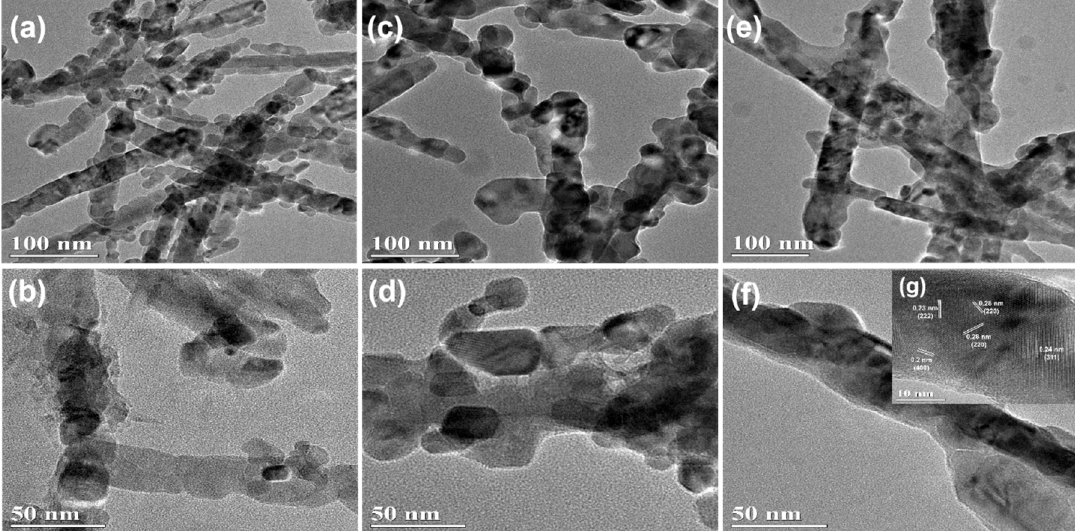
Figure 3. Transmission electron microscopy (TEM) image of ( a,b ) NiCo 2 O 4 , ( c,d ) CuCo 2 O 4 and ( e,f ) Cu 0.6 Ni 0.4 Co 2 O 4 ; ( g ) the inset showing the HRTEM image of Cu 0.6 Ni 0.4 Co 2 O 4 .